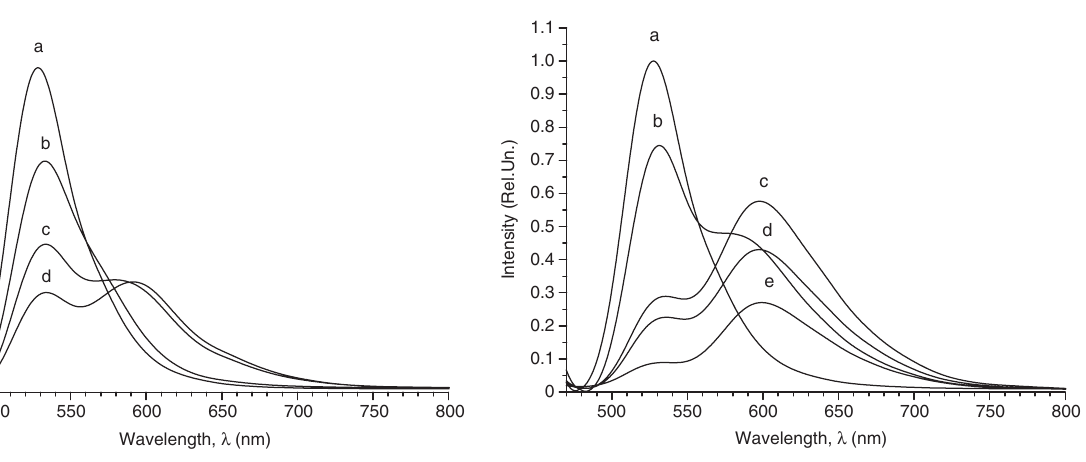
Figure 22 Fluorescence spectra for ternary complexes AO-DNA- Figure 20 Quenching of fluorescence by AgNPs in DNA-AO-EB EB. The complexes were prepared as follows: DNA solutions put in complex. (a) DNA-AO, (b) DNA-AO-EB-AgNPs (C ), (c) DNA-AO-EB- 1 hermetic test tubes were kept in vitro in thermal bath at a tempera- AgNPs (C ), (d) DNA-AO-EB-AgNPs (C ). [DNA] – 2.8 × 10 -4 mol/l 2 3 ture of 100 ° C for different periods of time (5, 10, and 20 min). (a) (P), [AO] – 0.14 × 10 -4 mol/l, [EB] – 0.14 × 10 -4 mol/l, [AgNPs] – 0 DNA-AO, (b) DNA-AO-EB (0 min), (c) DNA-AO-EB (5 min), (d) (C ), [AgNPs] – 6.0 × 10 -6 mol/l (C ), [AgNPs] – 18.0 × 10 -6 mol/l (C ), 1 2 3 [NaNO ] – 10 -2 mol/l. λ = 460 nm. 3